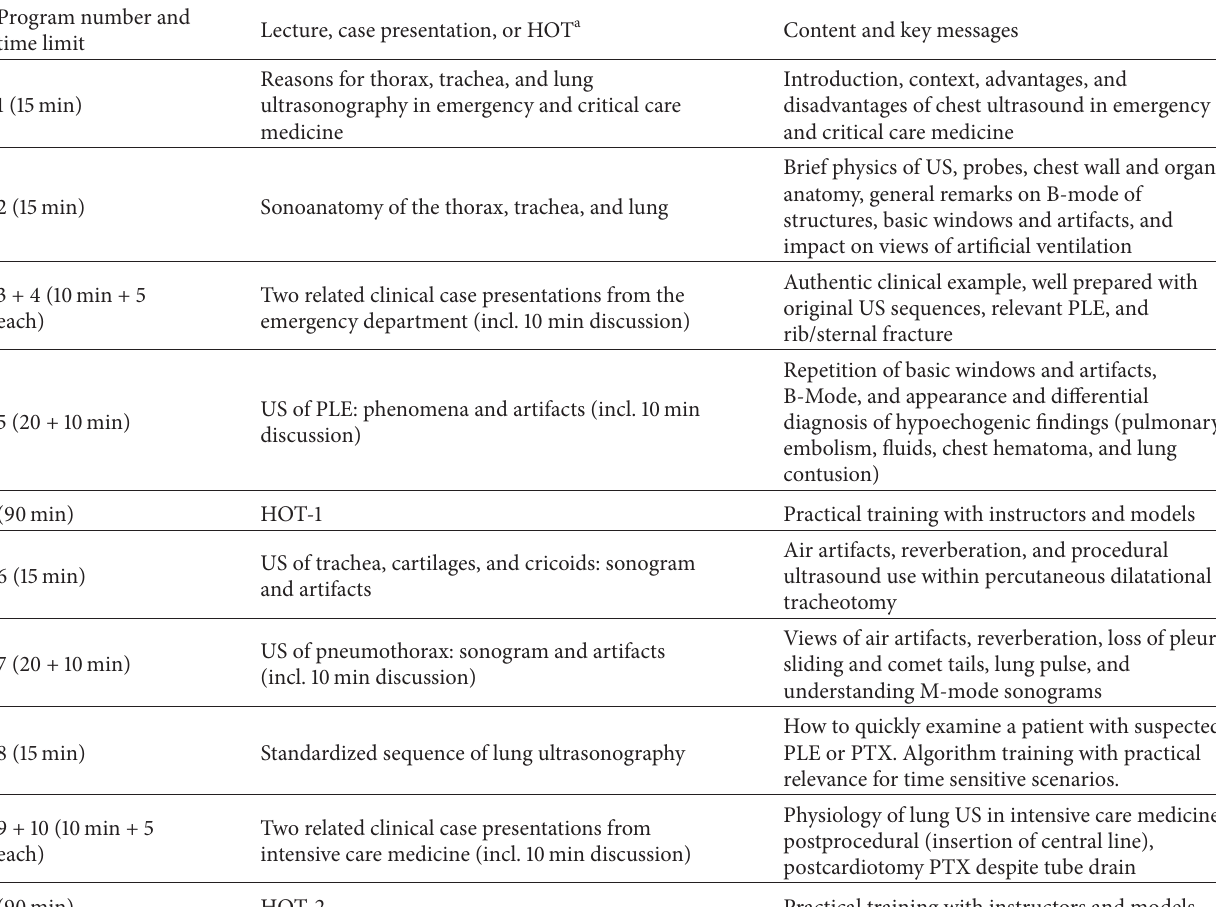
Table 1: Course structure of